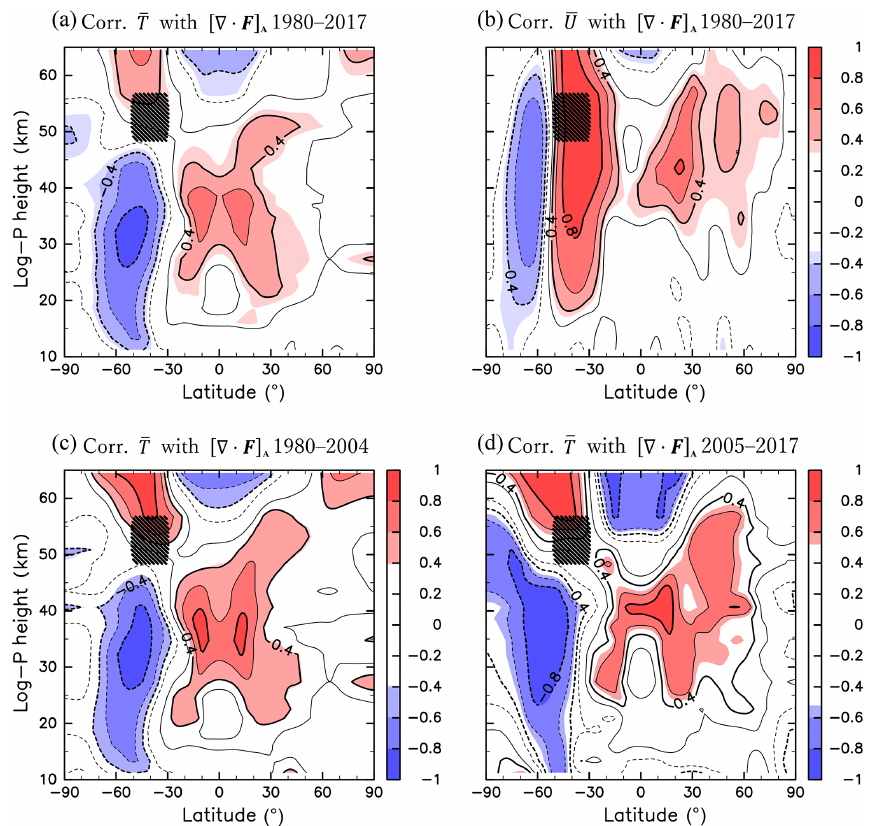
Figure 3. Same as Fig. 2 but for the correlations of [∇ · F ] A with (a) T (1980–2017), (b) u (1980–2017), (c) T (1980–2004), and (d) T